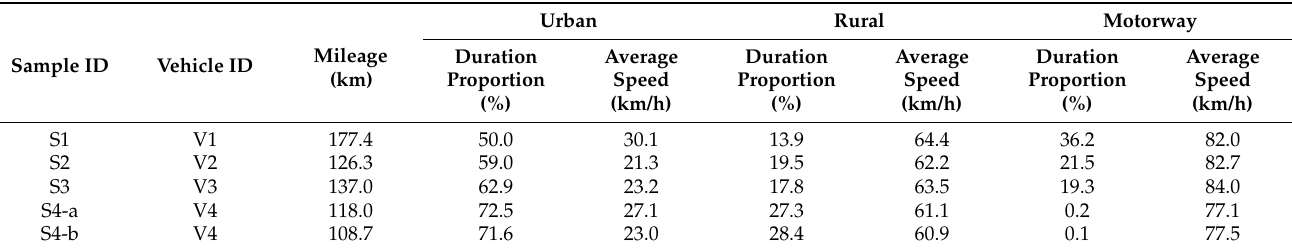
Table 2. Test route composition (urban, rural, motorway) *.